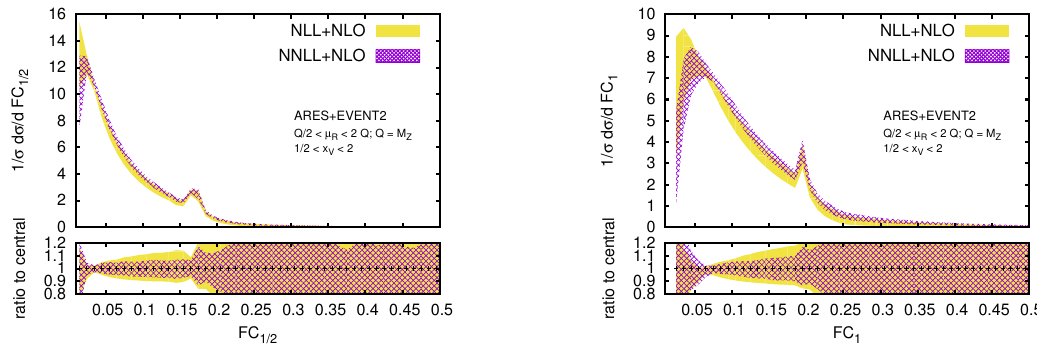
Figure 2 . NNLL+NLO and NLL+NLO distributions for the two moments of EEC FC at Q = M Z . The lower inset shows the ratio to the relative central value for each of the two